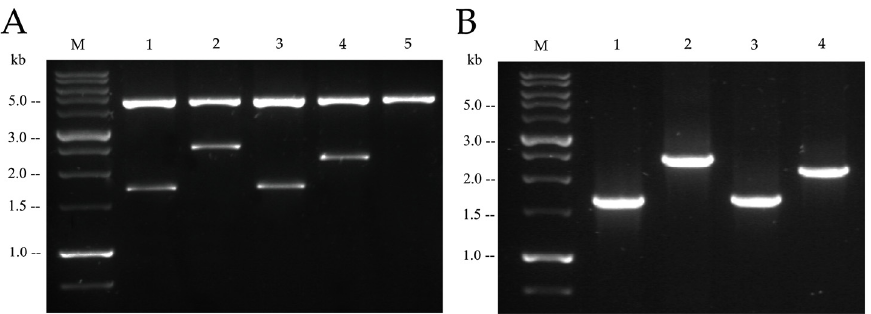
Figure 2. Cloning and expression of mcr-1–hpap2 and mcr-3–dgkA gene constructs in pBAD24. ( A ) Agarose gel electrophoresis of pBAD24 recombinant plasmids used in this work carrying the